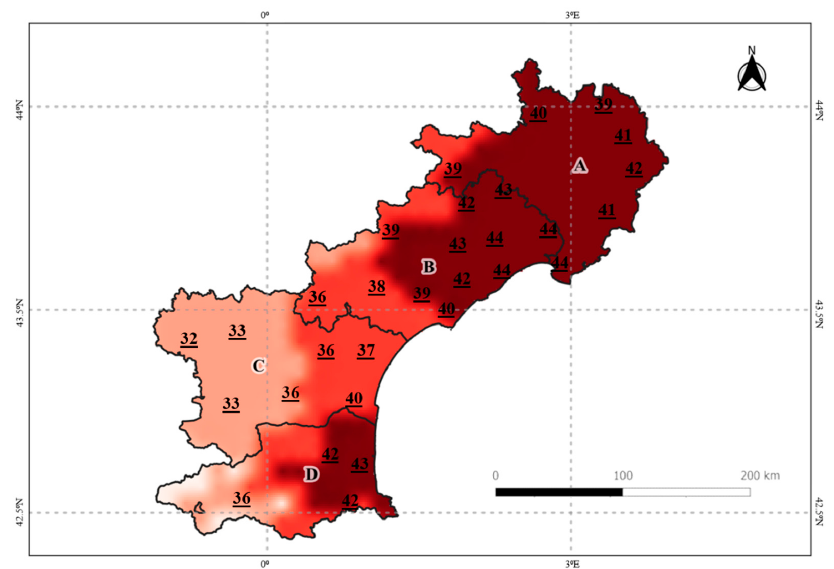
Figure 3. Map of maximum temperature recorded for 28th June 2019 in the Languedoc-Roussillon region. Source: SAFRAN grid, Météo-France.